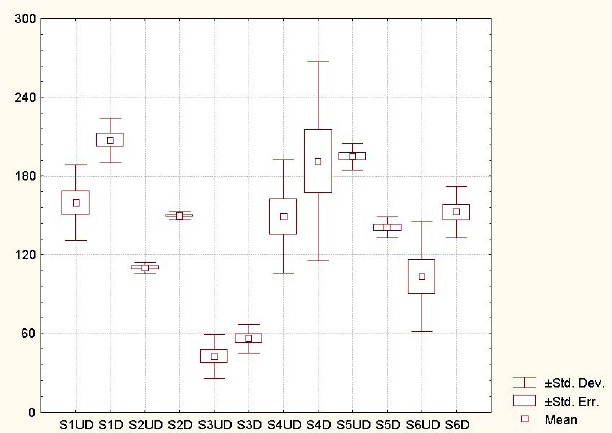
Figure 2: A box and whisker plot (of B amplitudes measured in 1 micro-volts) for each subject is shown. Subjects are labeled S1, S2 etc with UD indicating the un-dilated eye and D indicating the dilated eye. The means, standard errors and standard deviations for all eyes are